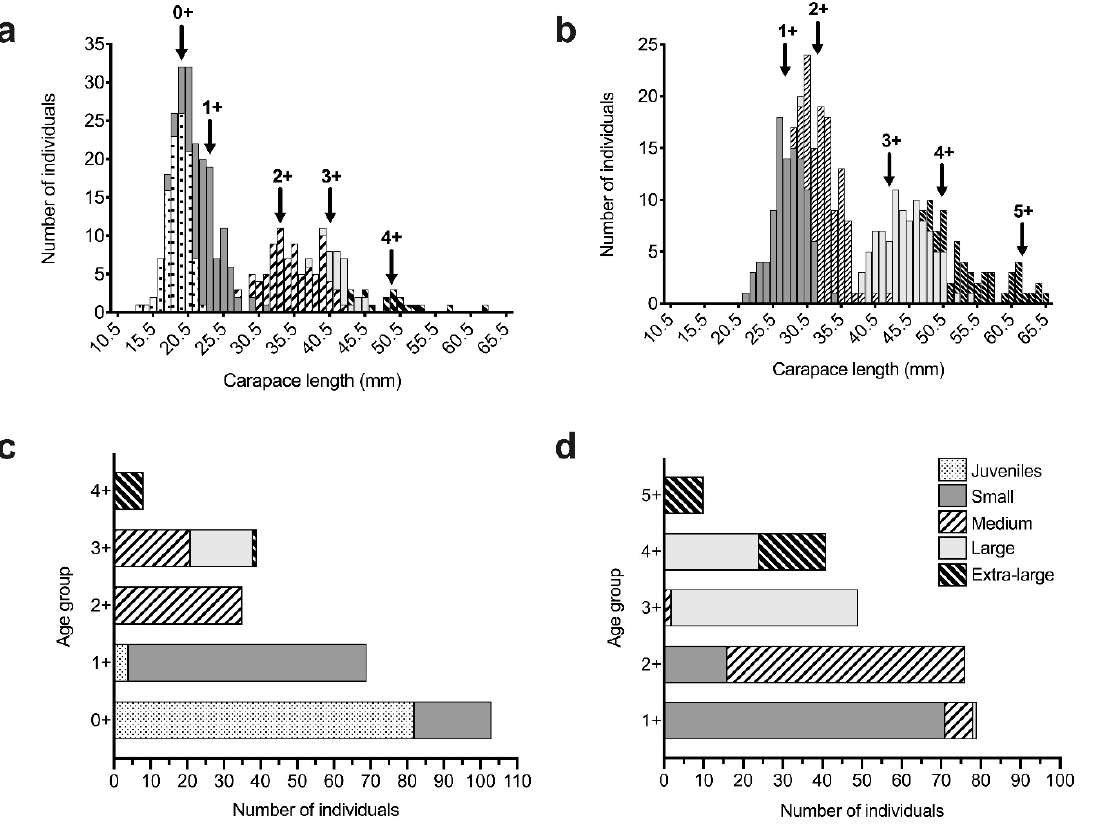
Figure 3. Size frequency distributions (carapace length, CL) of A. antennatus female groups in winter ( a ) and in summer ( b ) coupled with commercial size composition of each group derived from the modal progression analysis (MPA) in winter ( c ) and summer ( d ). Arrows indicate the CL mean computed for each age group by the MPA.